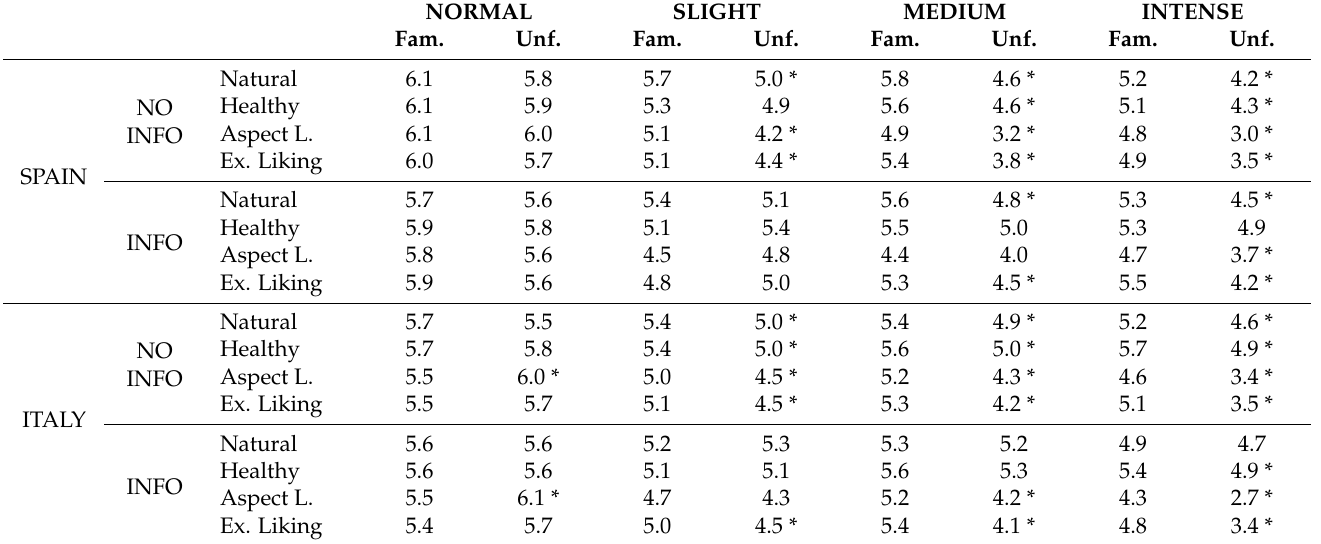
Table 1. Effect of familiarity with blood oranges on consumer perceptions of the natural and healthy character, and on the liking of appearance and expected taste (Ex. Liking), of mandarins with different pigmentation intensities. * indicates significant differences between the Familiar and Unfamiliar consumers for a specific pigmentation intensity according to the LSD test ( p -value = 0.05). NORMAL SLIGHT MEDIUM INTENSE Fam. Unf. Fam. Unf. Fam. Unf. Fam. Unf.